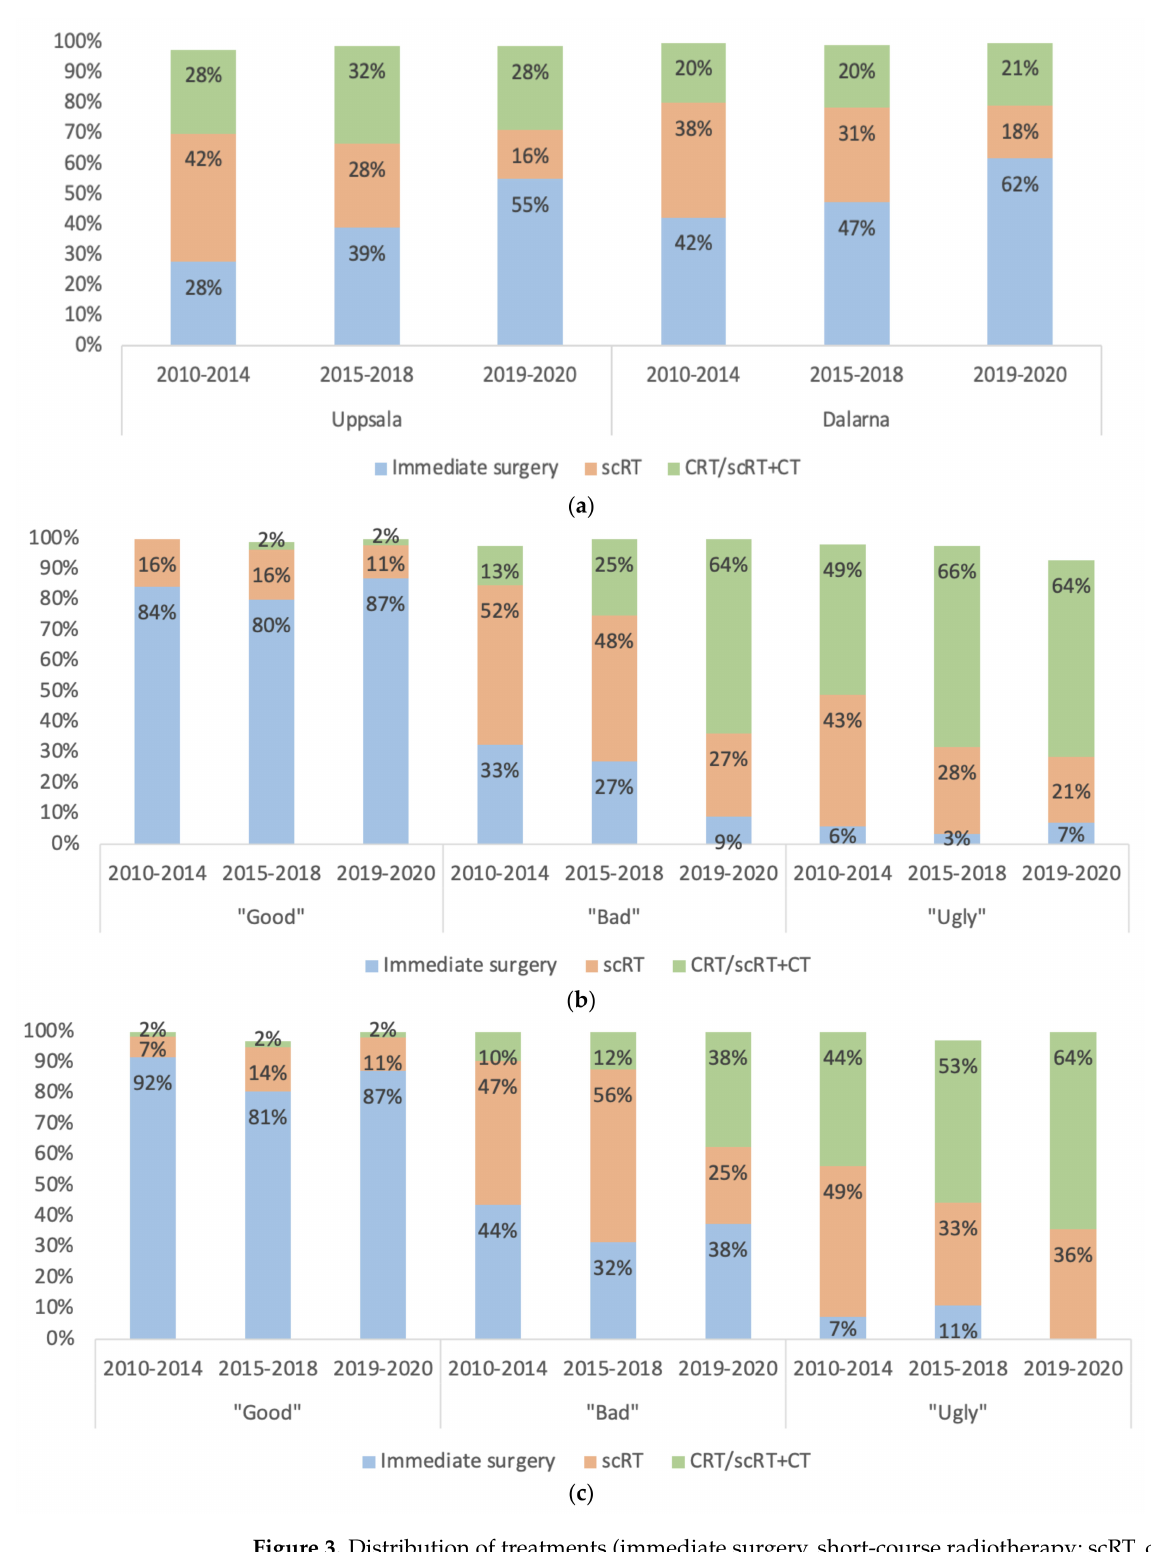
Figure 3. Distribution of treatments (immediate surgery, short-course radiotherapy; scRT, chemora- diotherapy/scRT + chemotherapy; CRT/scRT + CT) in ( a ) both regions and also in each risk group (Good, Bad, Ugly) in ( b ) Uppsala and ( c ) Dalarna region for the time periods during which different treatment guidelines were used (2008 guidelines in 2010–2014, 2016 guidelines in 2015–2018 and 2020 guidelines in 2019–2020). The columns do not add up to 100% since some patients were treated with other alternatives than the three dominating